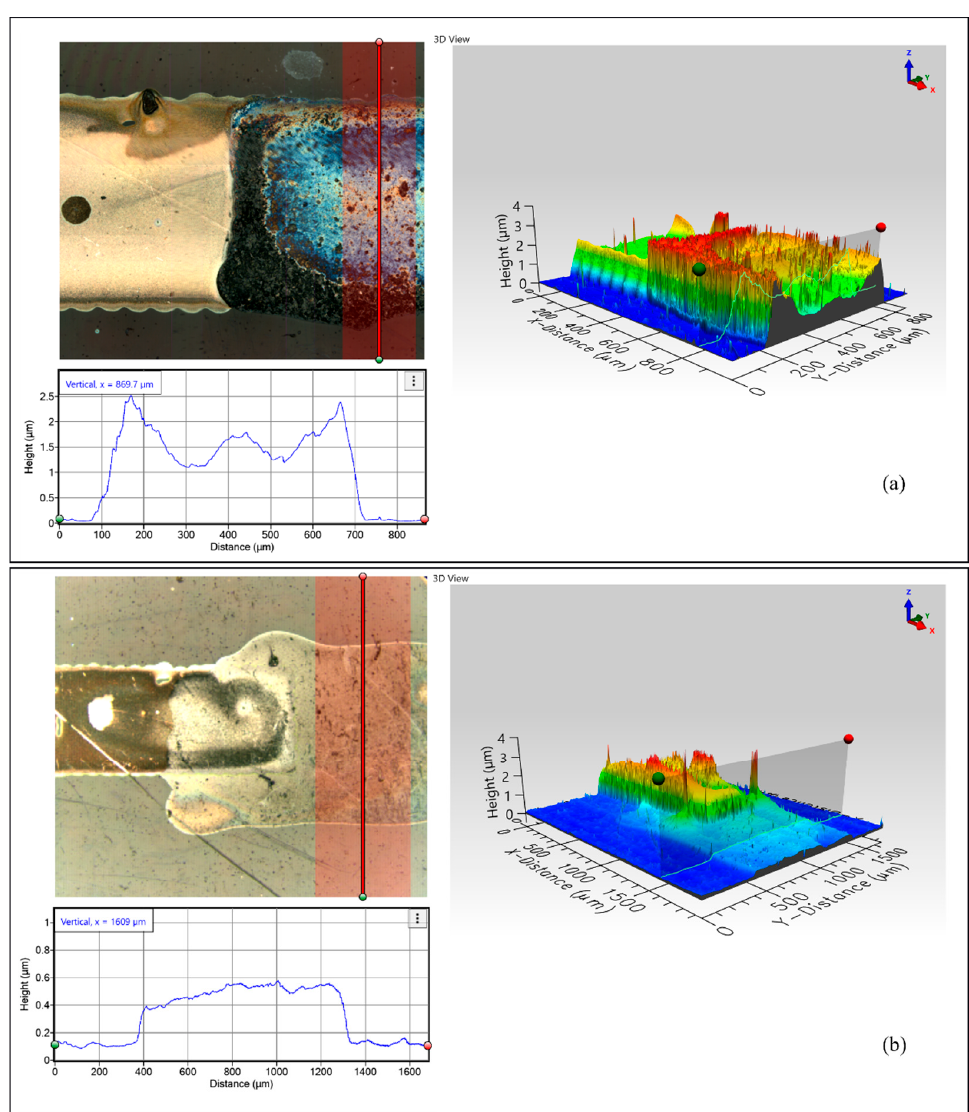
Figure 8. 3D measurement for AgNP– f -rGO ( a ) and AgNP–G ( b ) interconnections. The insets show height profiles of the f -rGO ( a ) and graphene ( b ) regions as indicated in the 2D top view obtained by TotalFocus™.